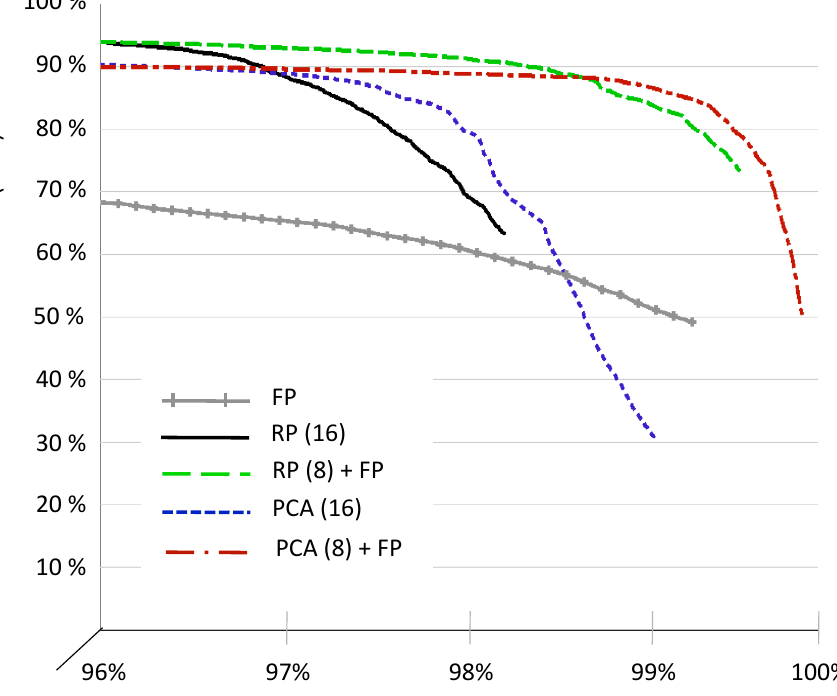
Figure 7. Pareto curves of the NDR/ARR relations for various classification methods obtained by averaging the different values extracted from the 4-fold cross validation